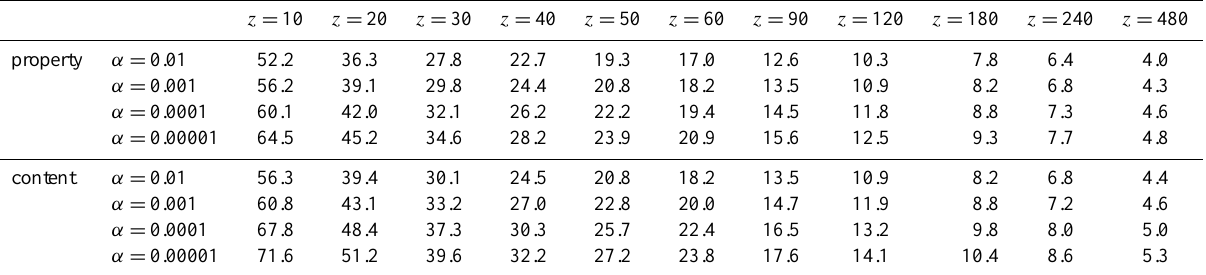
α = 0.0001 α = 0.00001 0.232